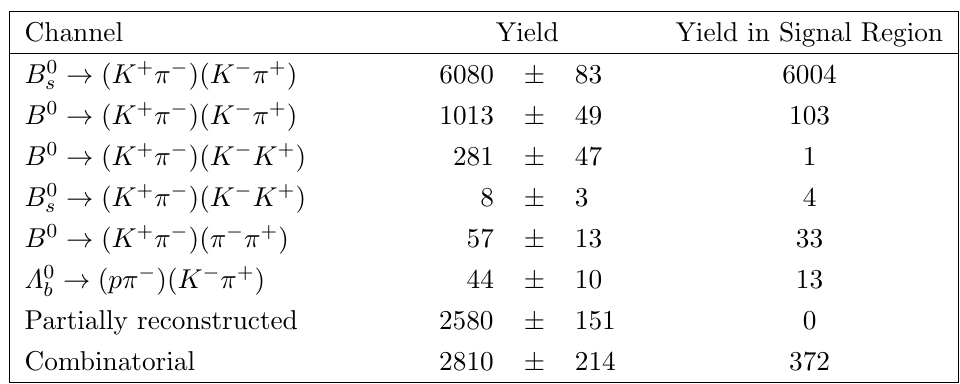
Table 2 . Yields of the signal decay and the various background components considered in the four-body invariant mass (cid:12)t. The uncertainties are statistical only. The signal region is de(cid:12)ned as